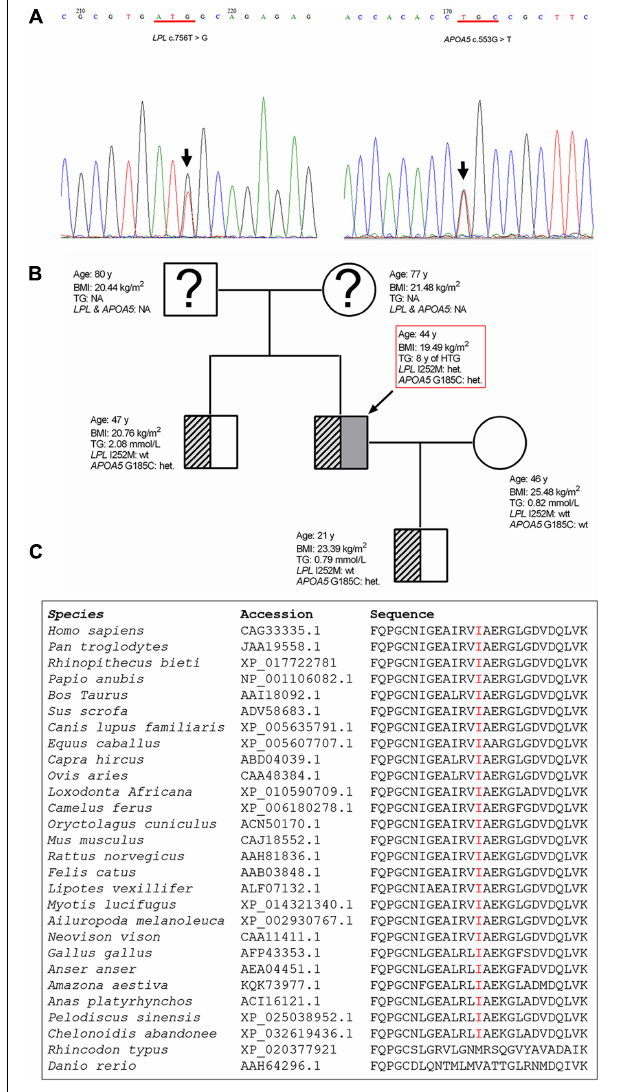
FIGURE 3 | Genetic variants detected in the patient and the family tree. (A) Sanger sequencing electropherogram showing the novel LPL c.756T > G (p.Ile252Met) variant and the known common APOA5 c.553G > T (p.Glu185Cys) variant identified in the patient. The variants are indicated by arrows. (B) Arrow denotes the patient. Genotype status with respect to the APOA5 c.553G > T and LPL c.756T > G variants, age, BMI and TG levels are provided for each subject. (C) Alignment of partial LPL amino acid sequences spanning the p.252 site. LPL , lipoprotein lipase; APOA5 , apolipoprotein A5; BMI, body mass index; het, heterozygous; wt, wild-type; TG, triglyceride; NA, not